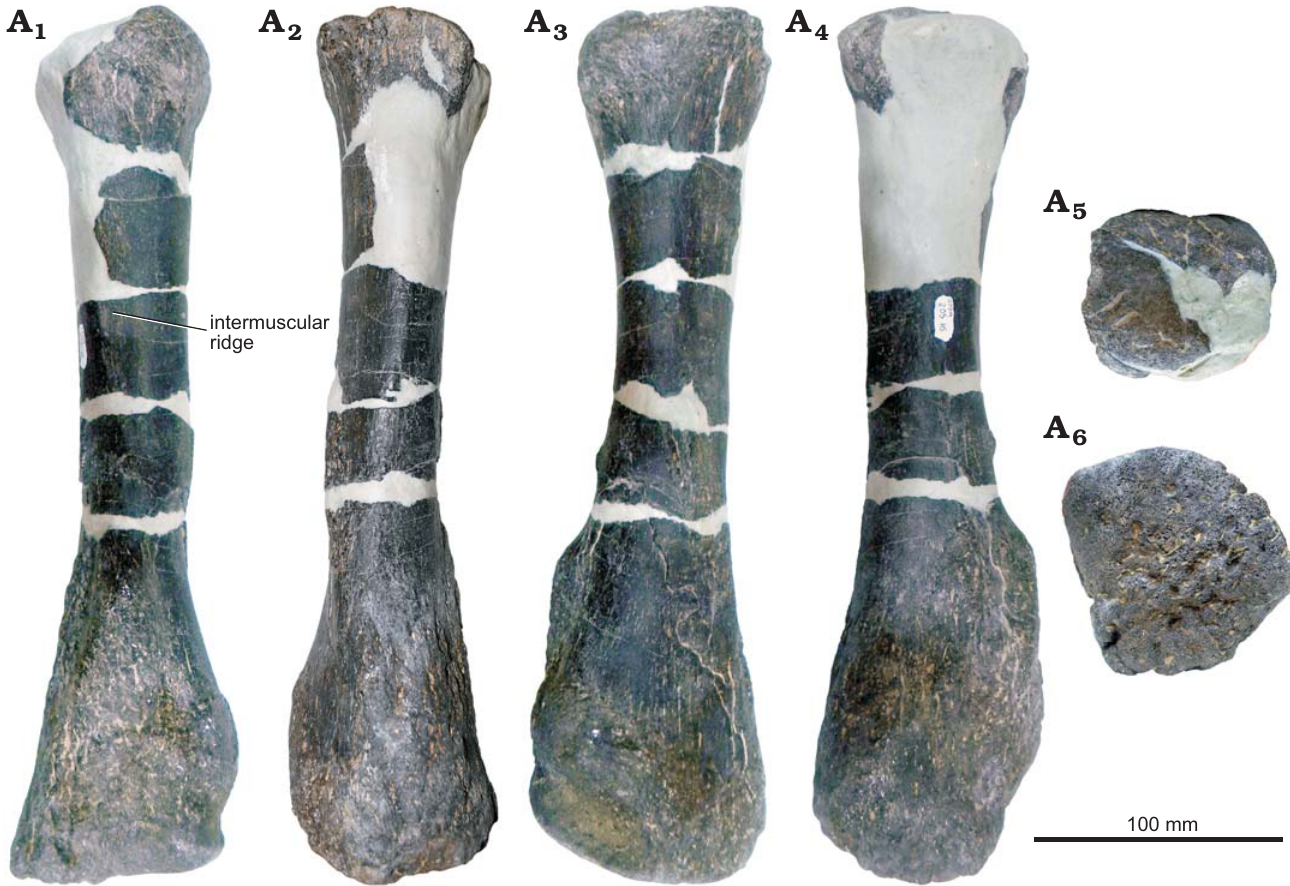
Fig. 5. Left radius of stegosaur GPDM 205 from the 5E Ranch, Little Snowy Mountains, Fergus County, Montana, USA; in lateral (A 1 ), medial (A 2 ), anterior (A 3 ), posterior (A 4 ), dorsal (A 5 ), and ventral (A 6 )